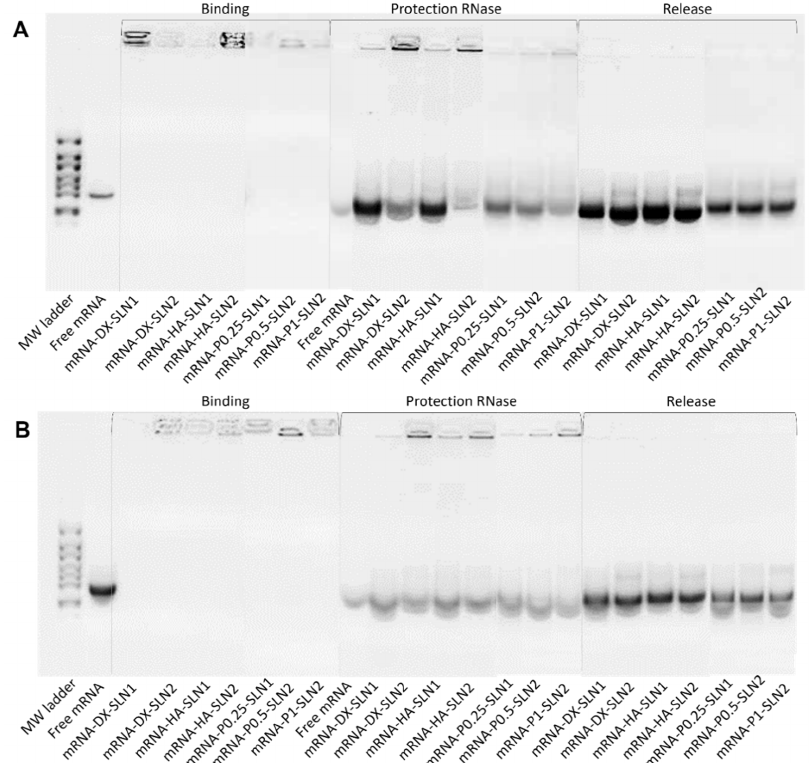
Figure 11. Long-term stability study of the binding, protection and release of mRNA-based vectors formulated with SLN1 and SLN2. ( A ) Binding, protection and release after one month of storage. ( B ) Binding, protection and release after three months of storage.